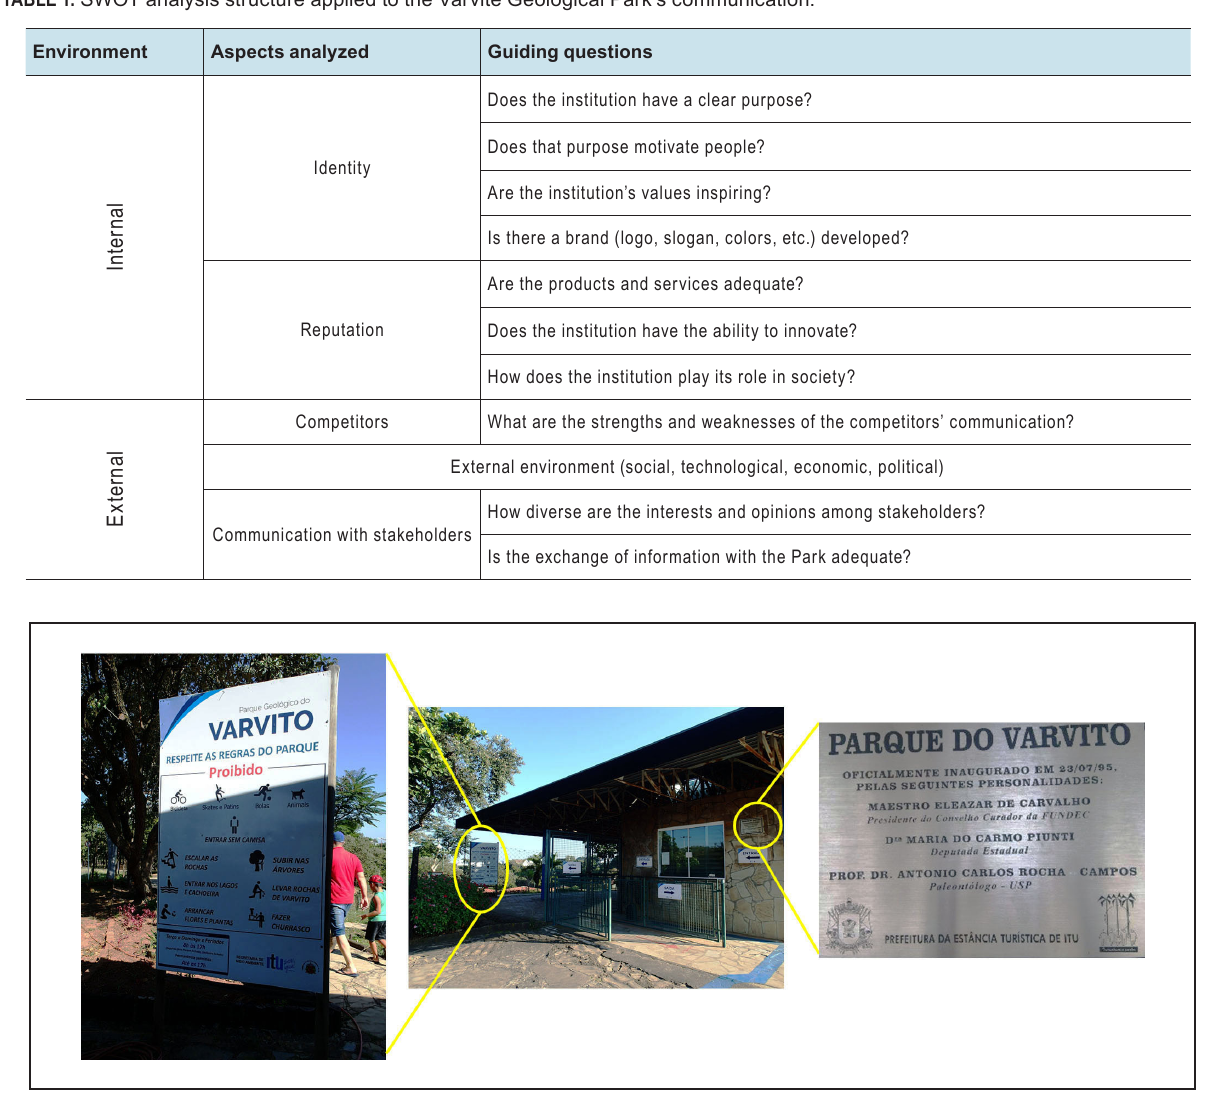
FIGURE 3 . Communication elements available at the Park's entrance (Photos: Andrea Duarte Cañizares,